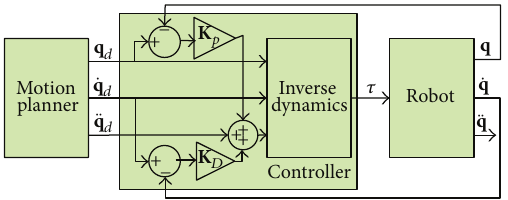
Figure 8: Dynamic simulation system block scheme.